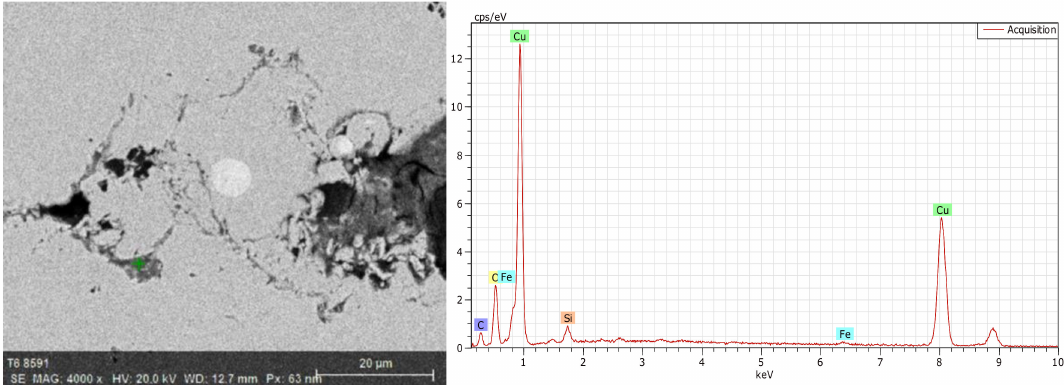
Figure 7. Energy spectrum analysis at the